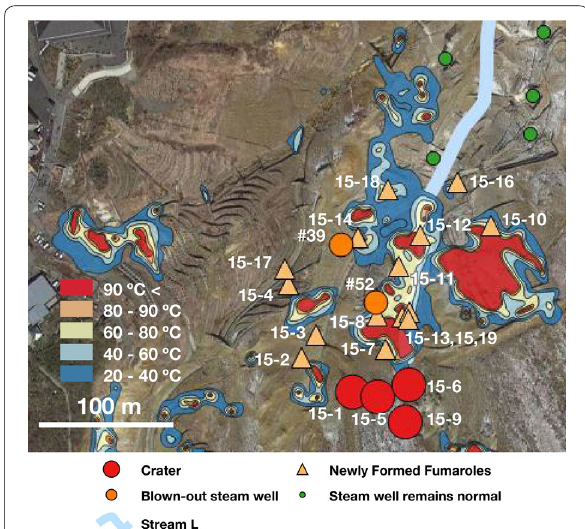
Fig. 15 Location of craters and fumaroles newly formed during the 2015 eruption (photograph source: Google Earth). Temperature distri- bution at 50 cm below the surface observed in February 2015 is also shown (courtesy of Odawara Public Works Center). Note that craters and many new fumaroles were formed where ground temperature was low before the eruption. Stream L runs through 15-12, 15-13 and originated from 15-6 and/or